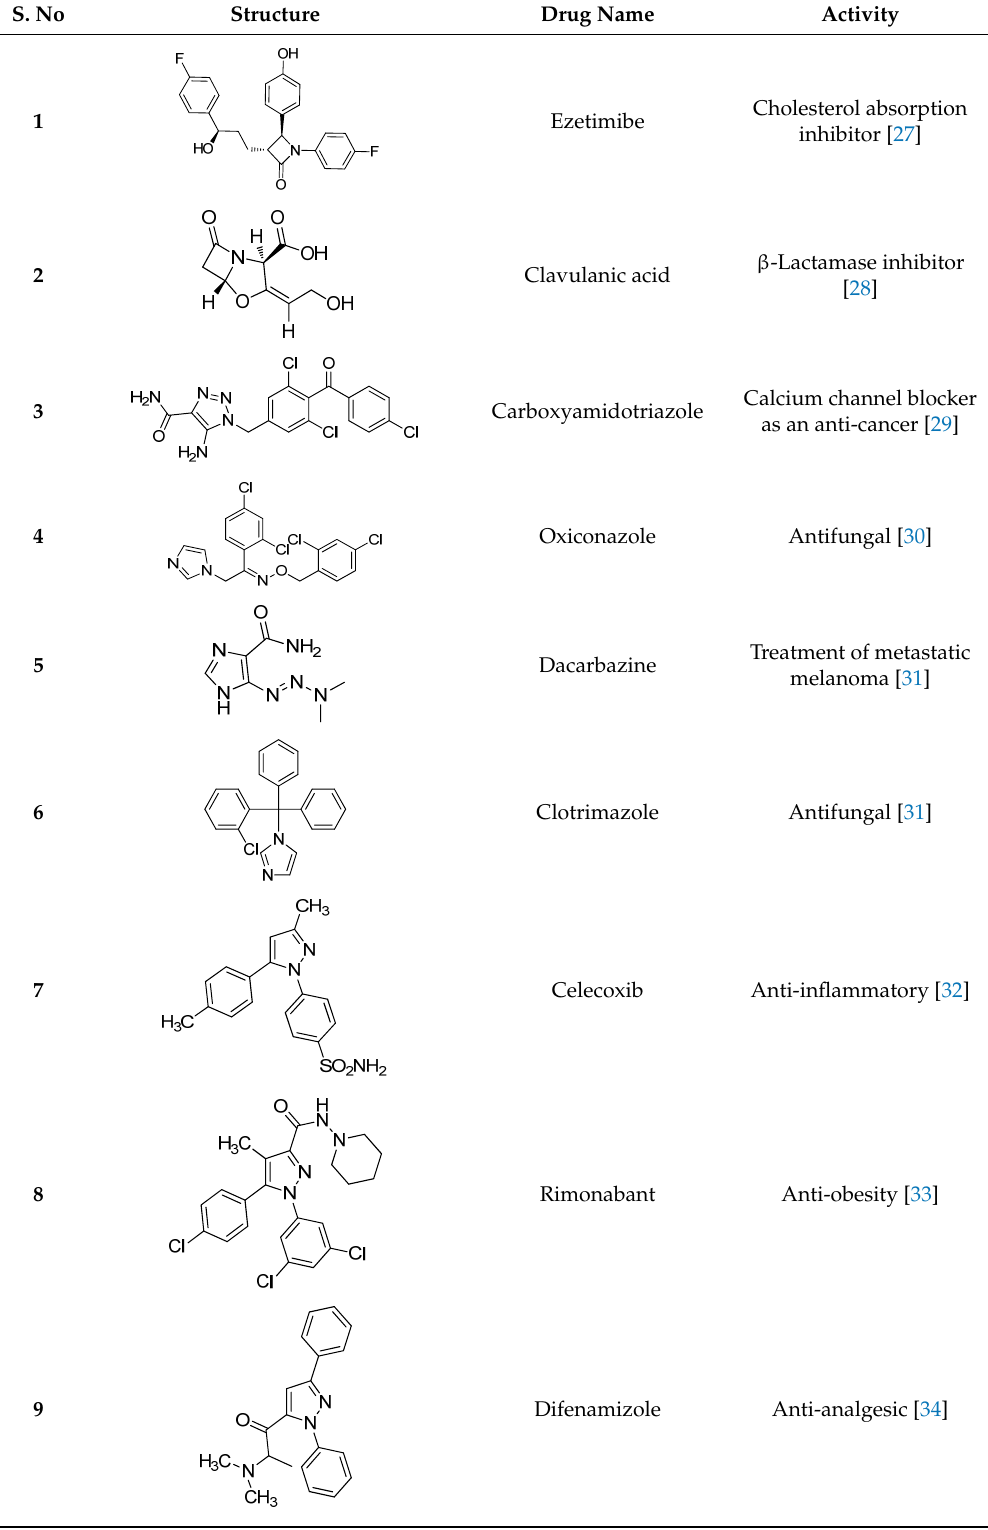
Table 1. List of nitrogen ‐ containing clinical drugs.